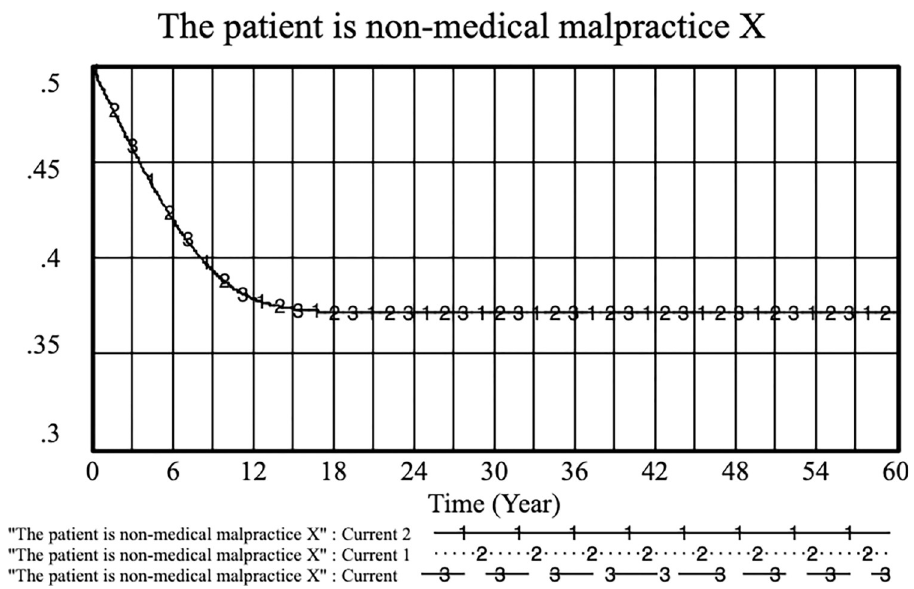
Fig 5. Effects of S 1 and S 2 on patients’ strategy selection. (current: S 1 = 0.1, S 2 = 0.8; current 1: S 1 = 0.2, S 2 = 0.7and current 2:S 1 = 0.3, S 2 = 0.6).